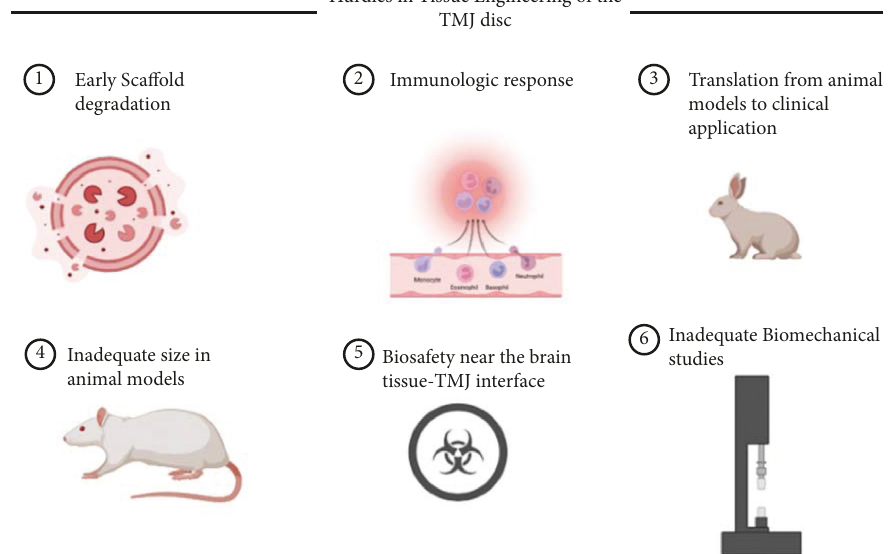
Figure 2: Hurdles in developing a practically useable TE TMJ disc.